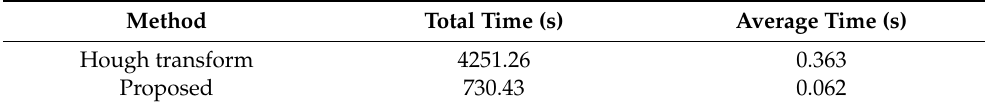
Table 4. The time consumption of the proposed method and the Hough transform method for dataset